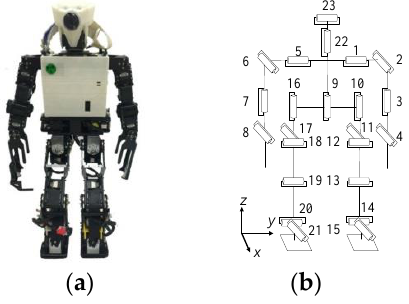
Figure 1. ( a ) Photograph of TKU-X. ( b ) Twenty-three degrees of freedom (DOFs) of TKU-X.